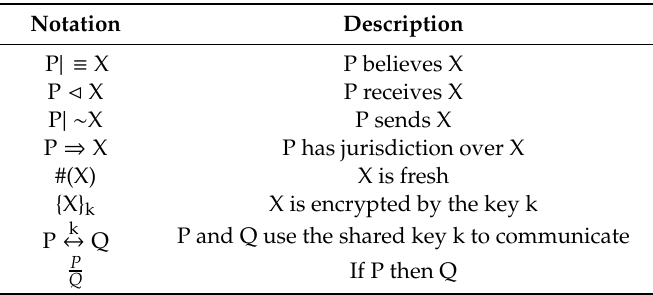
Table 2. BAN-logic